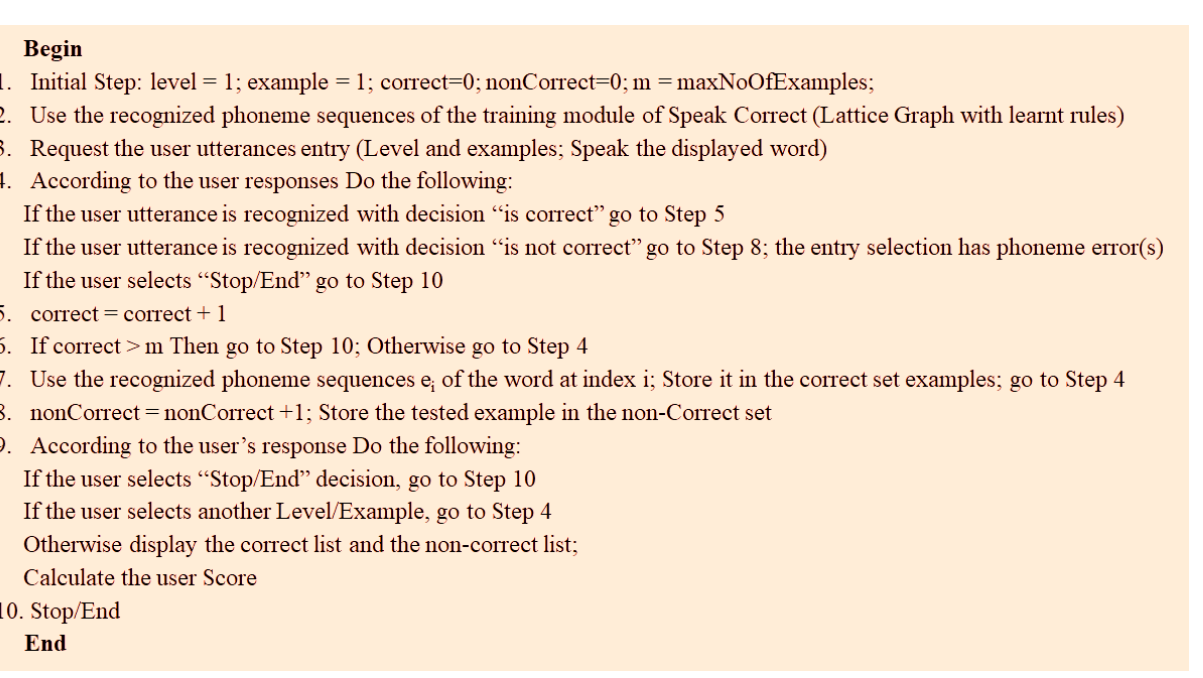
Figure 4. Speak Correct evaluation algorithm.